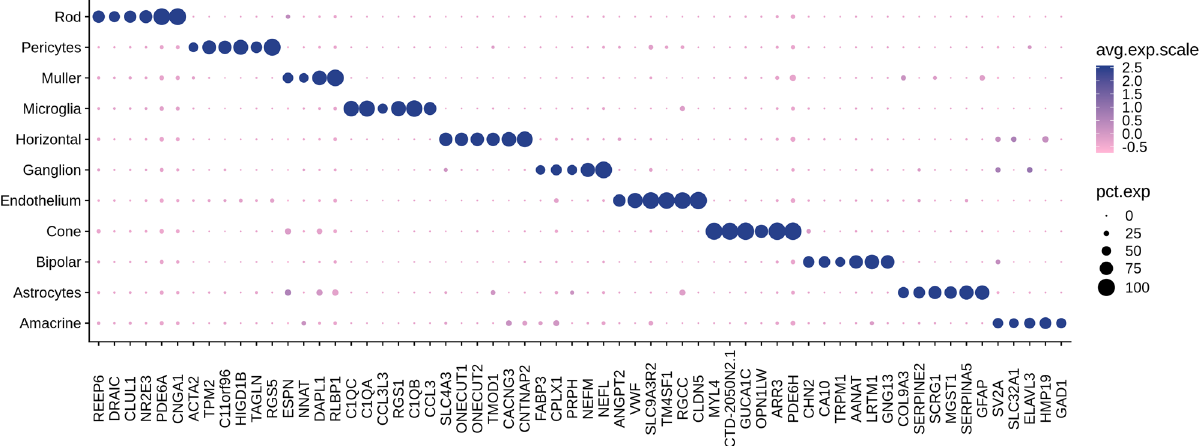
Figure 2. Dotplots showing the expression pattern of selected cell type specific markers across reina cell types. 6 top (ranked by percent of expression) specific markers for each retina cell type were selected and